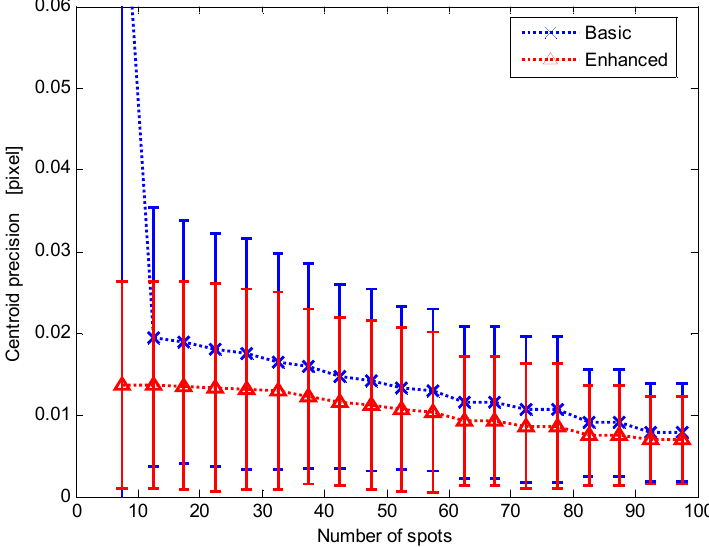
Figure 9. Centroid precision versus the number of spots for the basic and enhanced